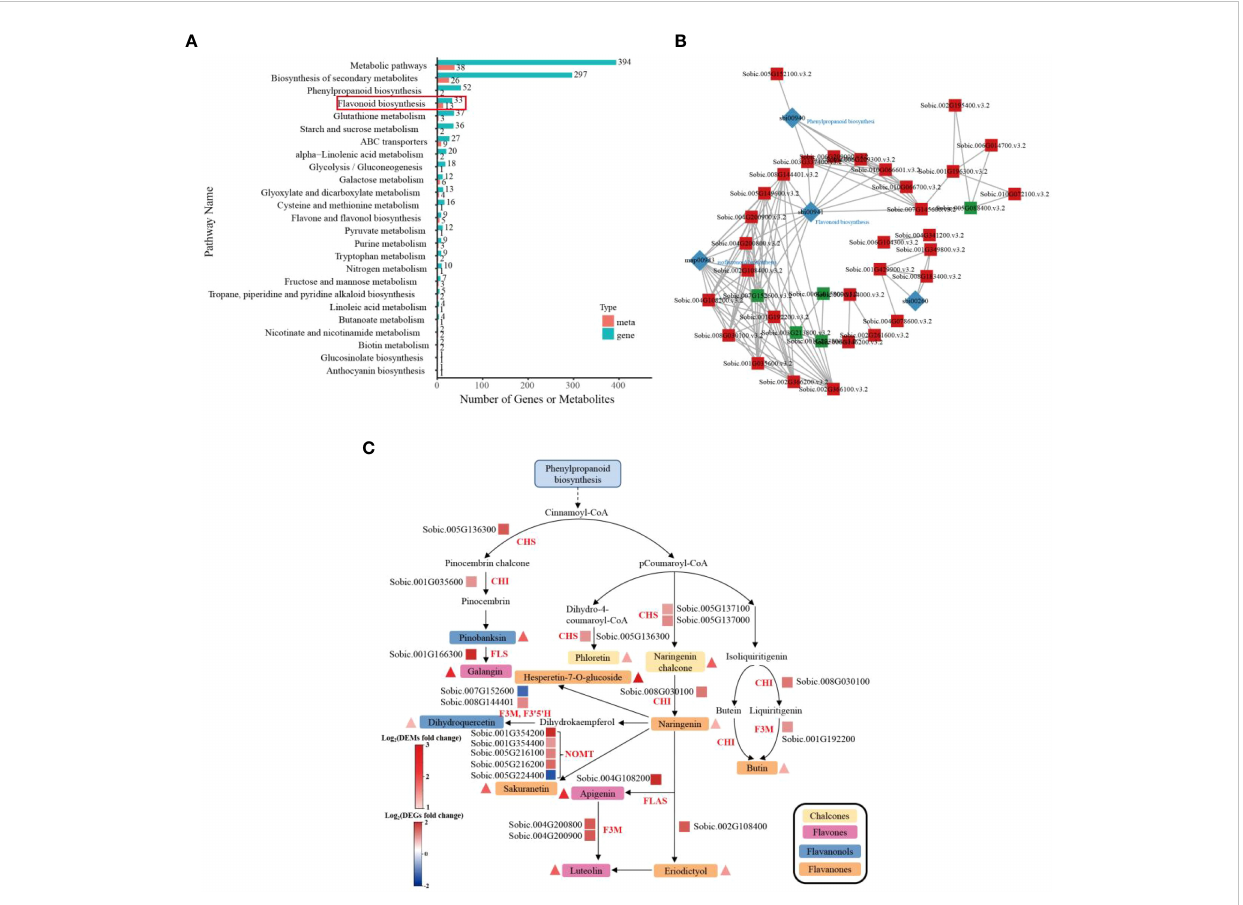
FIGURE 5 Transcriptomic and metabolomic analysis of sorghum roots under 0 and 10 m M Cd treatments. (A) KEGG enrichment analysis histogram of the DEGs and DEMs of sorghum roots. (B) KGML network of DEGs and DEMs. The square represents the gene or gene product (red: up-regulated, green: down-regulated), and the diamond represents the pathway. (C) Parallel displays of DEGs and DEMs involved in fl avonoid biosynthesis in sorghum roots in response to Cd stress. The triangle and rectangle represent the metabolites and genes regulated under Cd treatment, respectively (red, up- regulation; blue, down-regulation). The types of metabolites are distinguished by long rectangular boxes with different colors (CHS, chalcone synthase; CHI, chalcone- fl avonone isomerase; FLS, fl avonol synthase; F3M, fl avonoid 3 ’ -monooxygenase; F3 ’ 5 ’ H, fl avonoid 3 ′ ,5 ′ -hydroxylase; NOMT, naringenin 7-O-methyltransferase; FLAS, fl avonol synthase